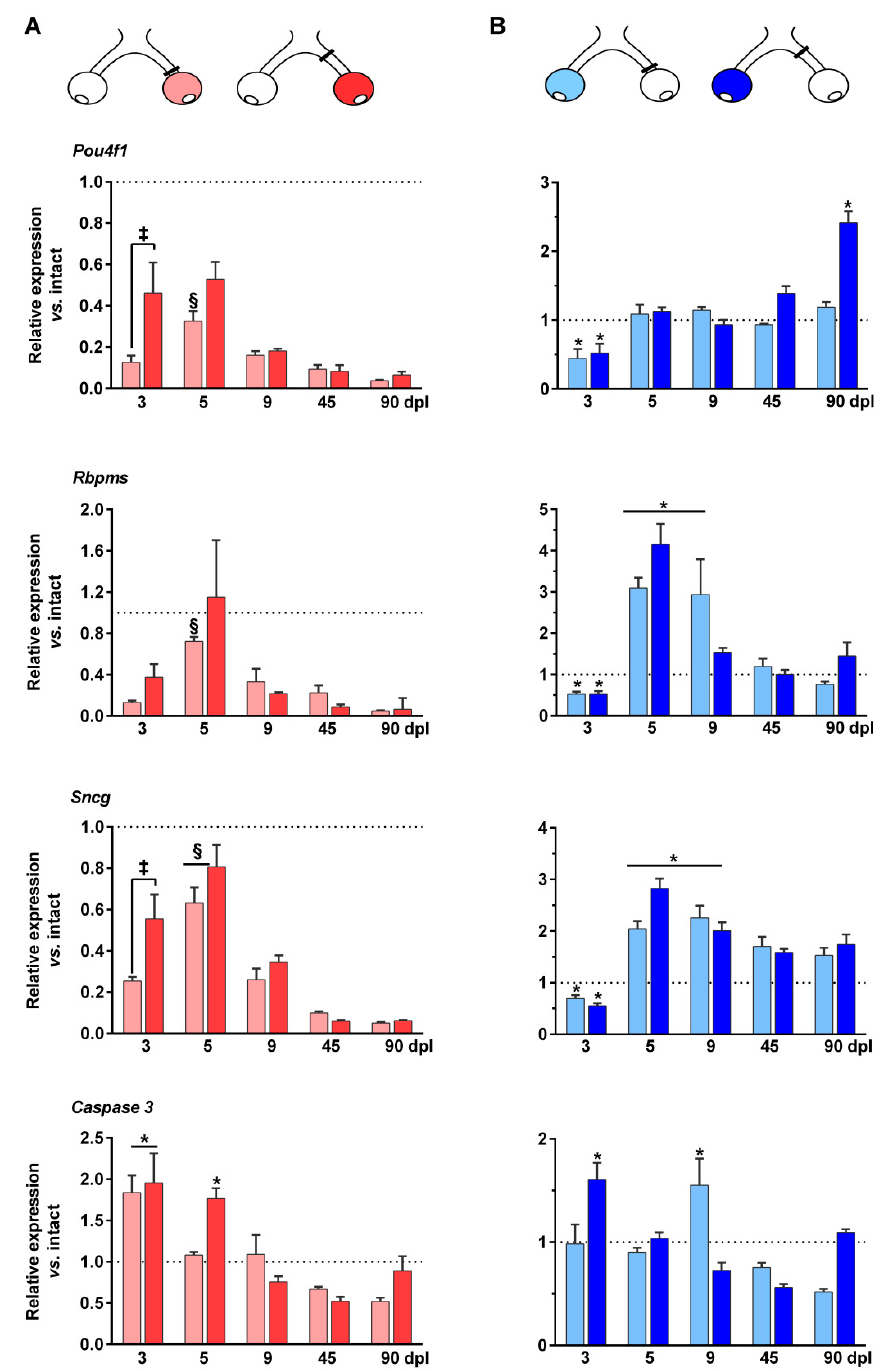
Figure 5. Expression levels of RGC markers and caspase 3 in the contralateral and injured retinas. Bar graphs showing the expression level ± S.E.M. of Pou4f1 (Brn3a), Rbpms (protein RNA-binding protein with multiple splicing) , Sncg ( γ -synuclein) and Caspase 3 , transcripts in the injured (( A ) red) and contralateral (( B ) blue) retinas at increasing time points after ONC 0.5 mm (light red or blue) and ONC 2 mm (dark red or blue) compared to intact retinas (value 1, dotted lines). In the injured retinas, the expression of Pou4f1, Rbpms , and Sncg was significantly lower than in intact retinas at all time points and in both groups except for Rbmps at 5 days post-lesion and Sncg at 5 days in the ONC 2 mm group. * Significant compared to intact retinas. § Significant compared to the previous time point, ‡ Significant between ONC 0.5 and ONC 2 mm ( p < 0.05, ANOVA). 2.5. Up-Regulation of Caspase 3 mRNA Expression in the Injured and Contralateral Retinas